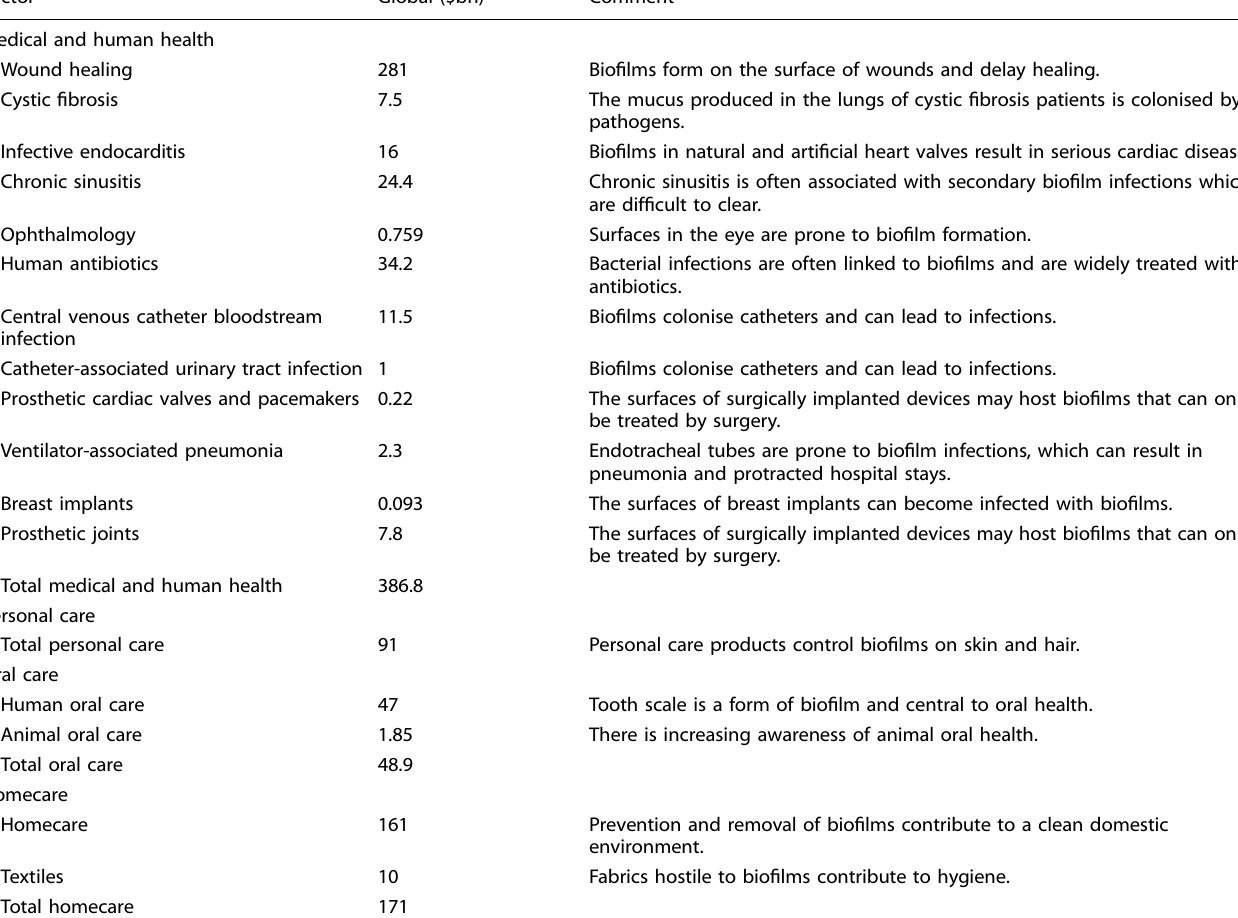
Table 1. Quanti fi cation of market sectors engaging with bio fi lm technologies — summary of economic information 6 .